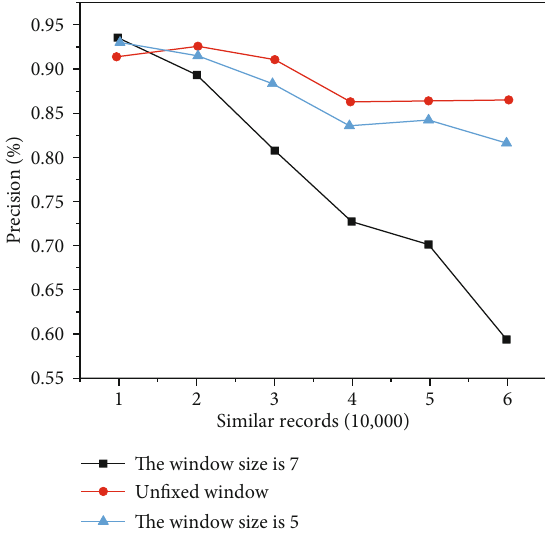
Figure 6: Comparison of accuracy.